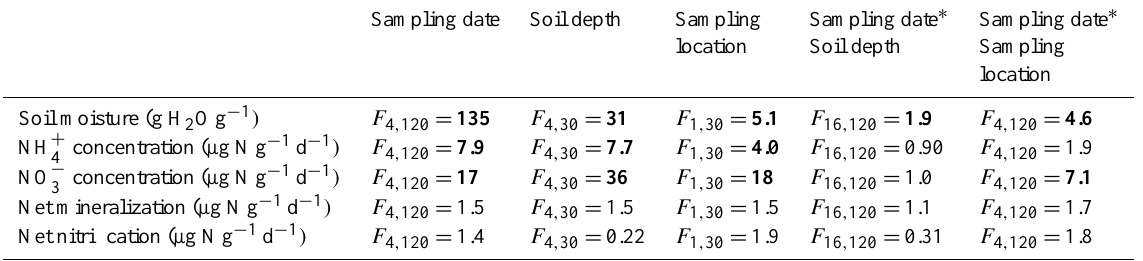
Table 3. Results from repeated measures ANOVAs with sampling date, the interaction of sampling date and soil depth, and the interaction of sampling date and sampling location as the within-subjects, and soil depth and sampling location as the between-subjects factors.